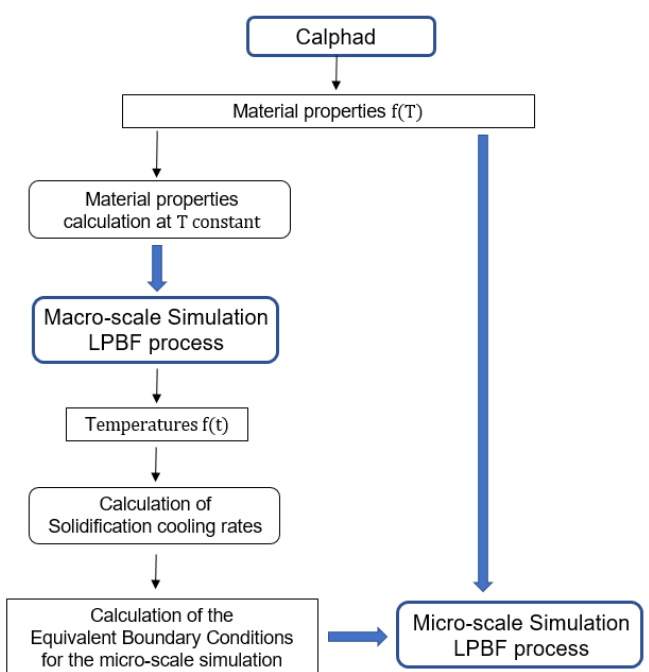
Figure 5. Flow chart of the multiscale models' connection.